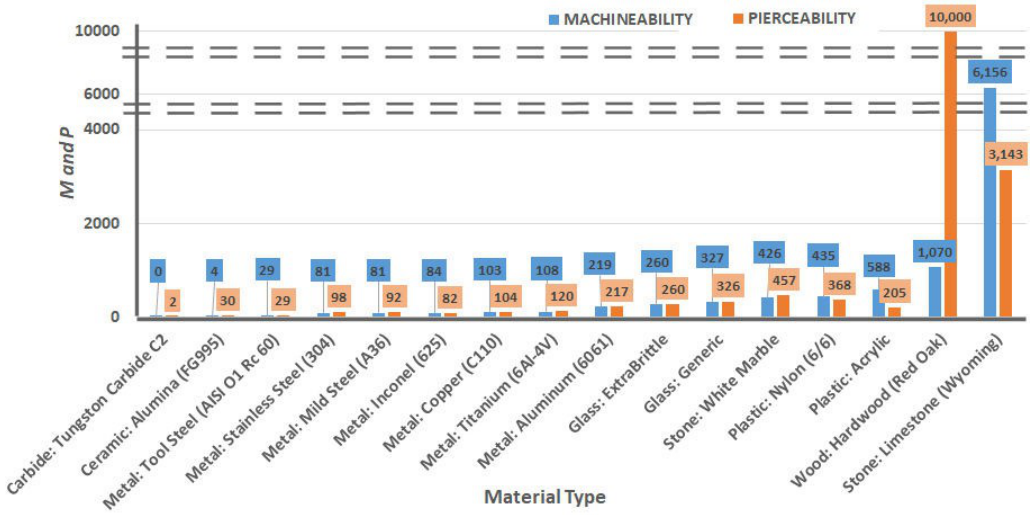
Figure 1: Machineability and pierceabiility of common